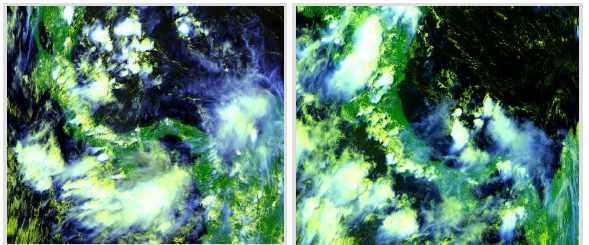
Fig. 3. Cloud scenes over Costa Rica on 22 July (left panel) and 5 August 2007 (right panel) during the NASA TC4 experiment. Blue colors indicate cirrus clouds, white is deep convection, and yellow indicates liquid water clouds. These color composites were generated by mapping the 0.47, 0.86 and 11-µm channels into the red, green and blue color intensities, respectively. For more details see Appendix